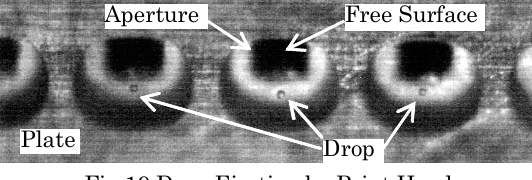
Free SurfaceAperture